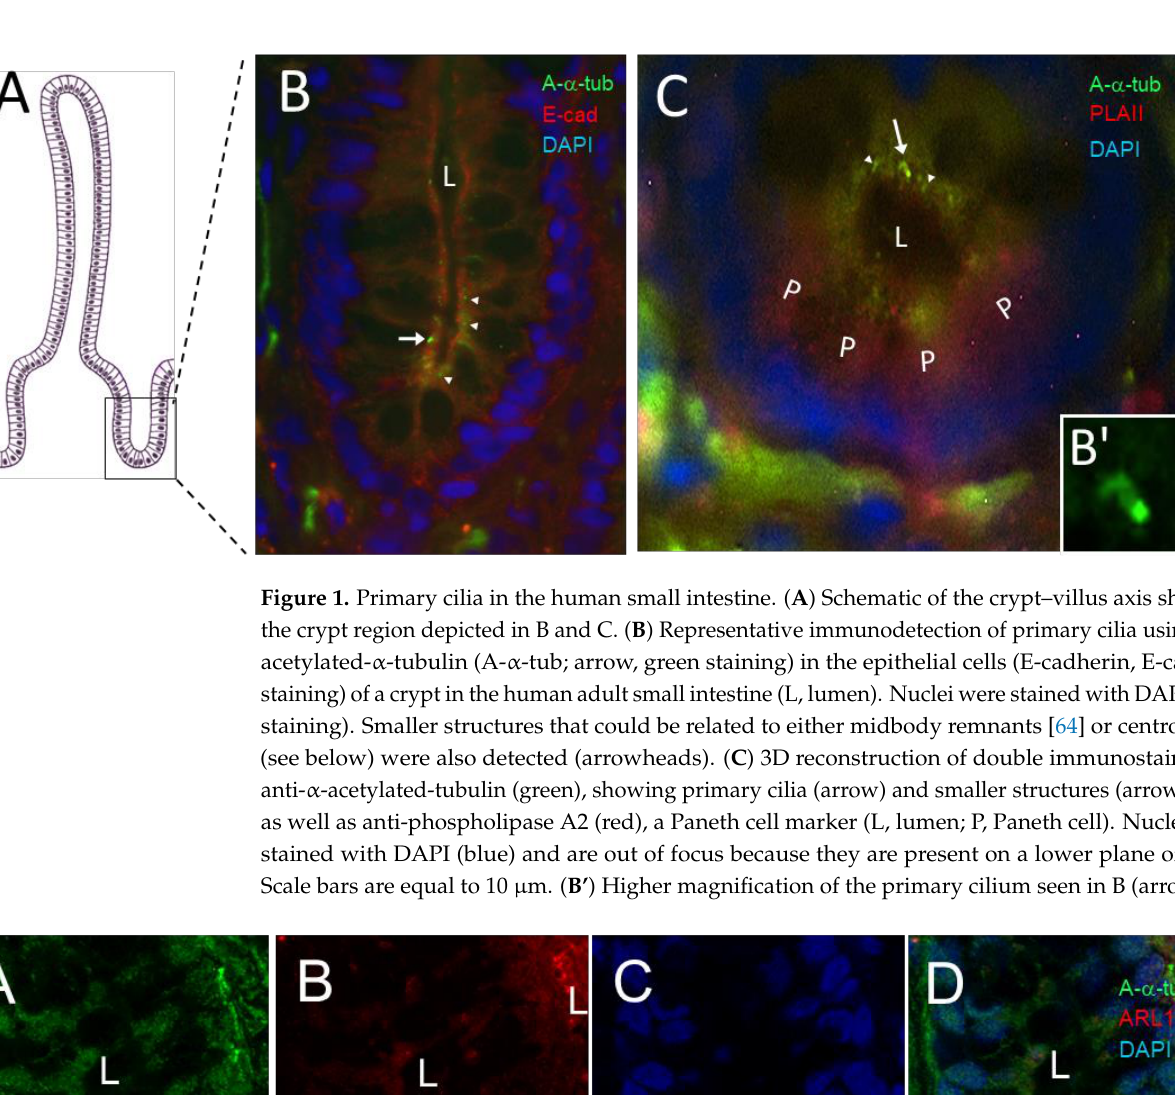
Cells 2023 , 12 , x FOR PEER REVIEW 5 of 24 GTPase ARL13b as a second marker for the primary cilium [62,63] to validate our obser-